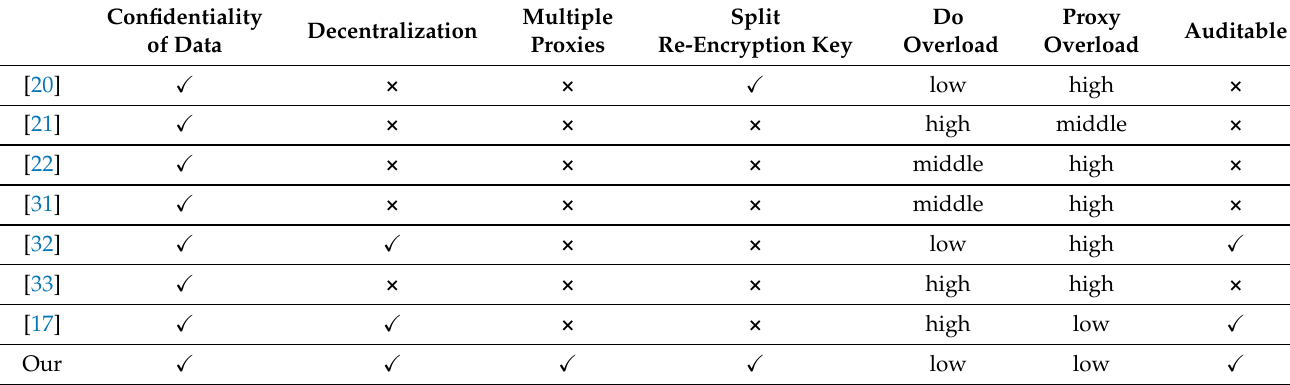
Table 1. Functional